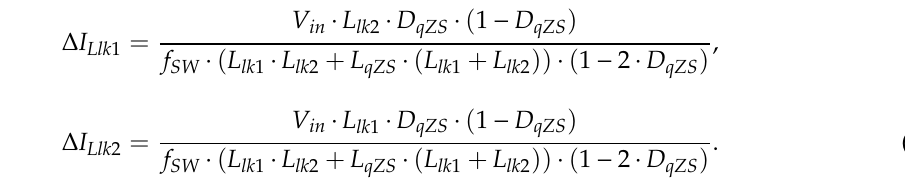
Figure 10. Dependences of the ST duty cycles on the input voltage boost factor.